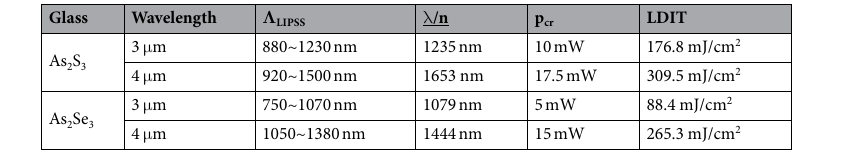
Table 1. Λ LIPSS and LDIT of As 2 S 3 and As 2 Se 3 glasses with the 150 fs laser at different